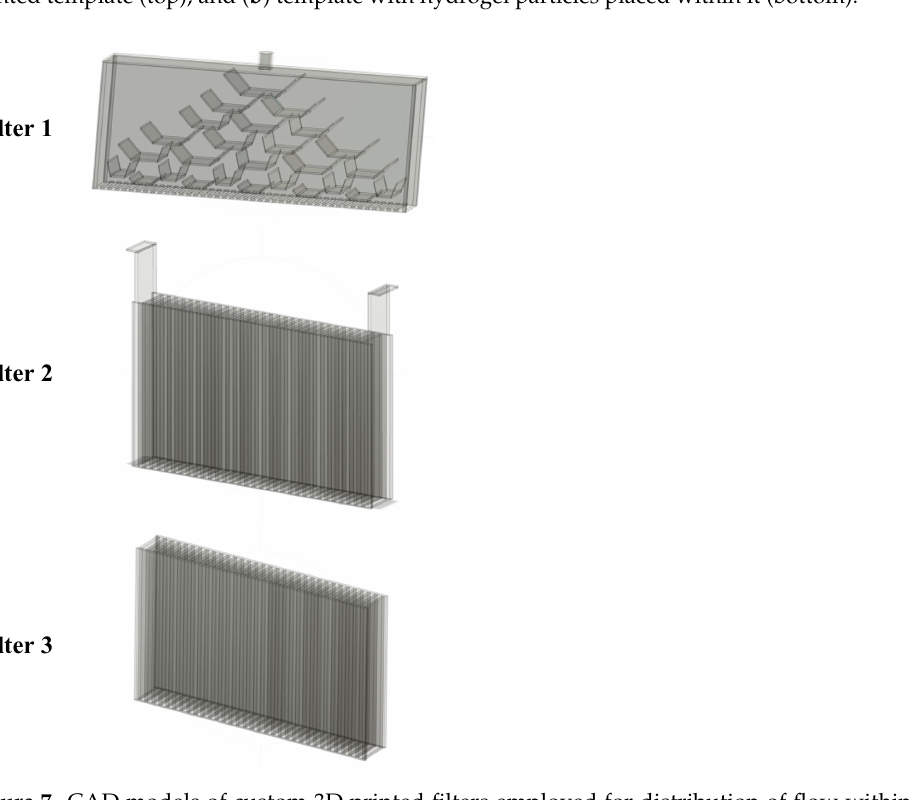
Figure 7. CAD models of custom 3D printed filters employed for distribution of flow within the model (corresponding to filters shown in Figure 5).